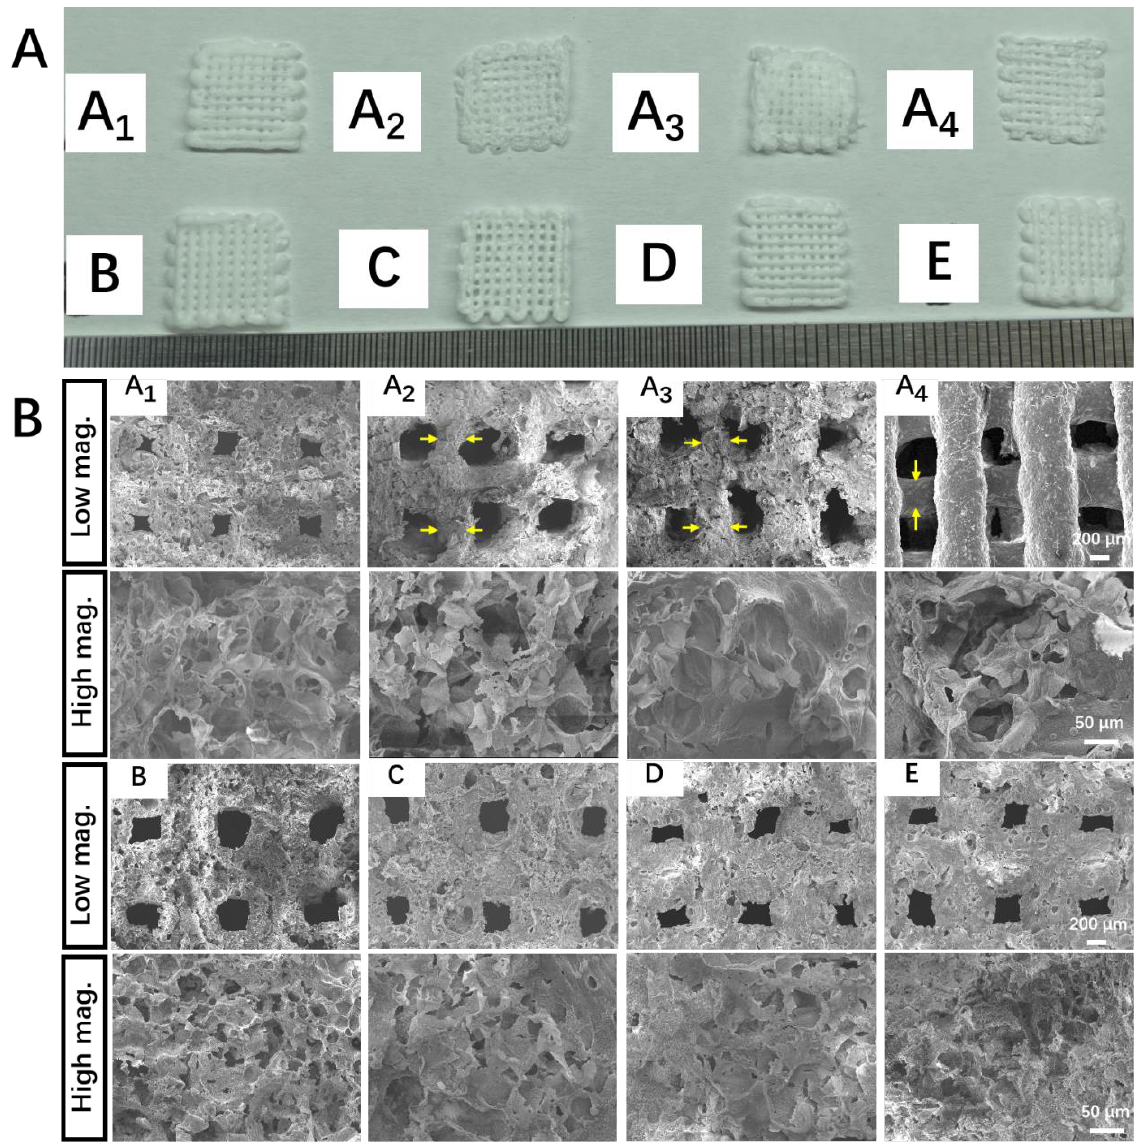
Figure 3. Morphology of porous scaffolds made from w/o Pickering emulsion inks. ( A ) Digital images of printed scaffolds. ( B ) SEM micrographs of different scaffolds (yellow arrows represent the thinning of the struts). A1 to E represent the top view of scaffolds made through A1 to E Pickering emulsion inks at low magnification (50 × ) and high magnification (350 × ), respectively.